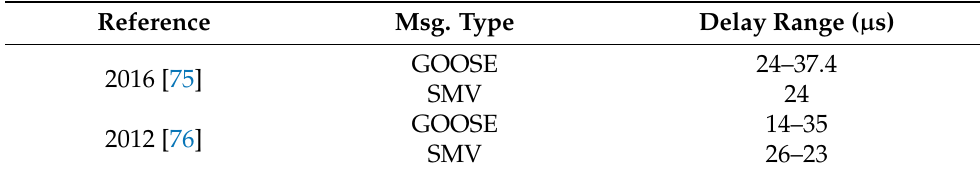
Table 11. IEC 61850 protocol delays.